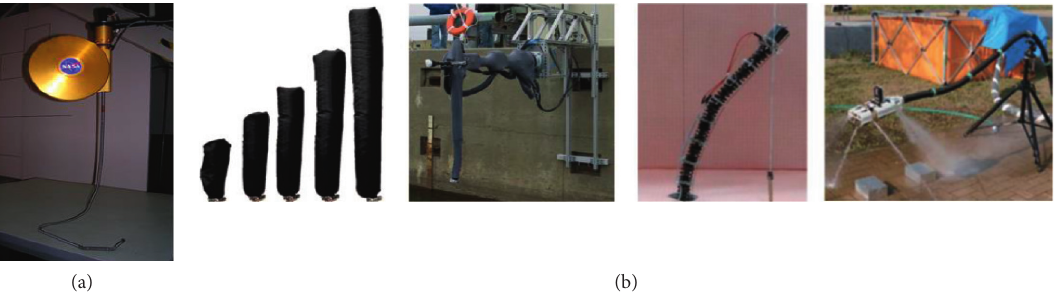
Figure 6: Continuum robots: (a) vine [163, 178] and (b) plant inspired [171, 181].